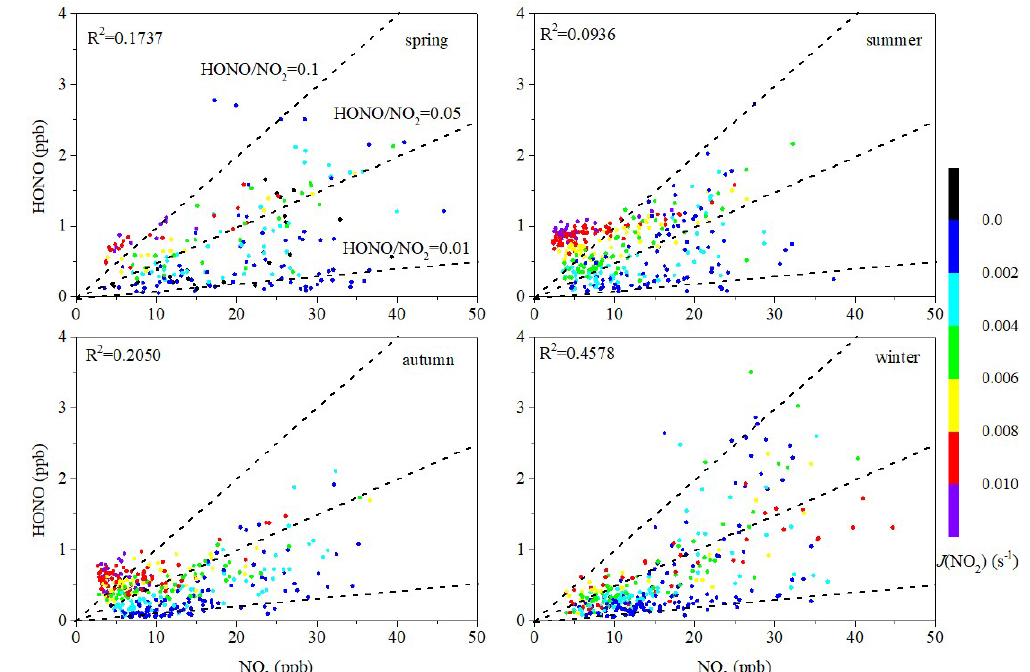
Figure 4. Scatter plots of NO 2 versus HONO color coded by J (NO 2 ). The three dashed lines represent 10%, 5%, and 1% ratios of HONO / NO 2 . Daytime was 06:00–18:00LT, including